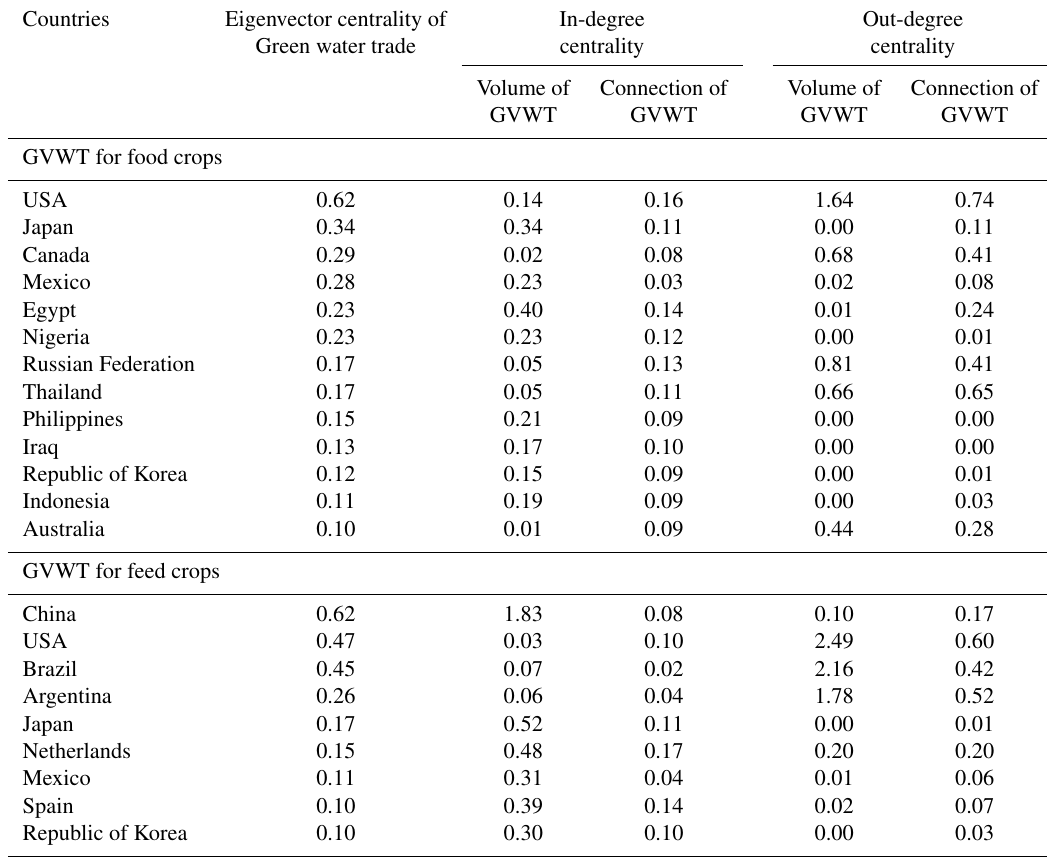
Table 5. Eigenvector centrality of green water trade and degree centrality of GVWT.